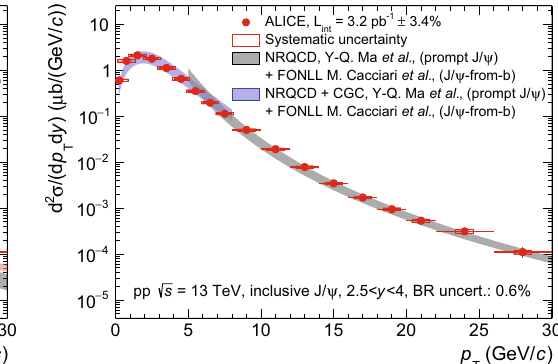
Right panel The non-prompt J /ψ contribution estimated with FONLL is summed to the two calculations for prompt J /ψ production and com- pared to the same